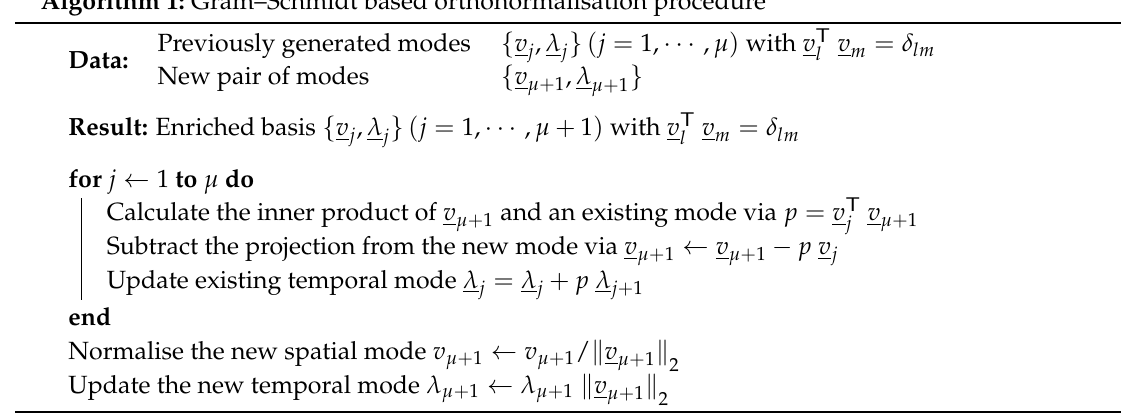
Algorithm 1: Gram–Schmidt based orthonormalisation